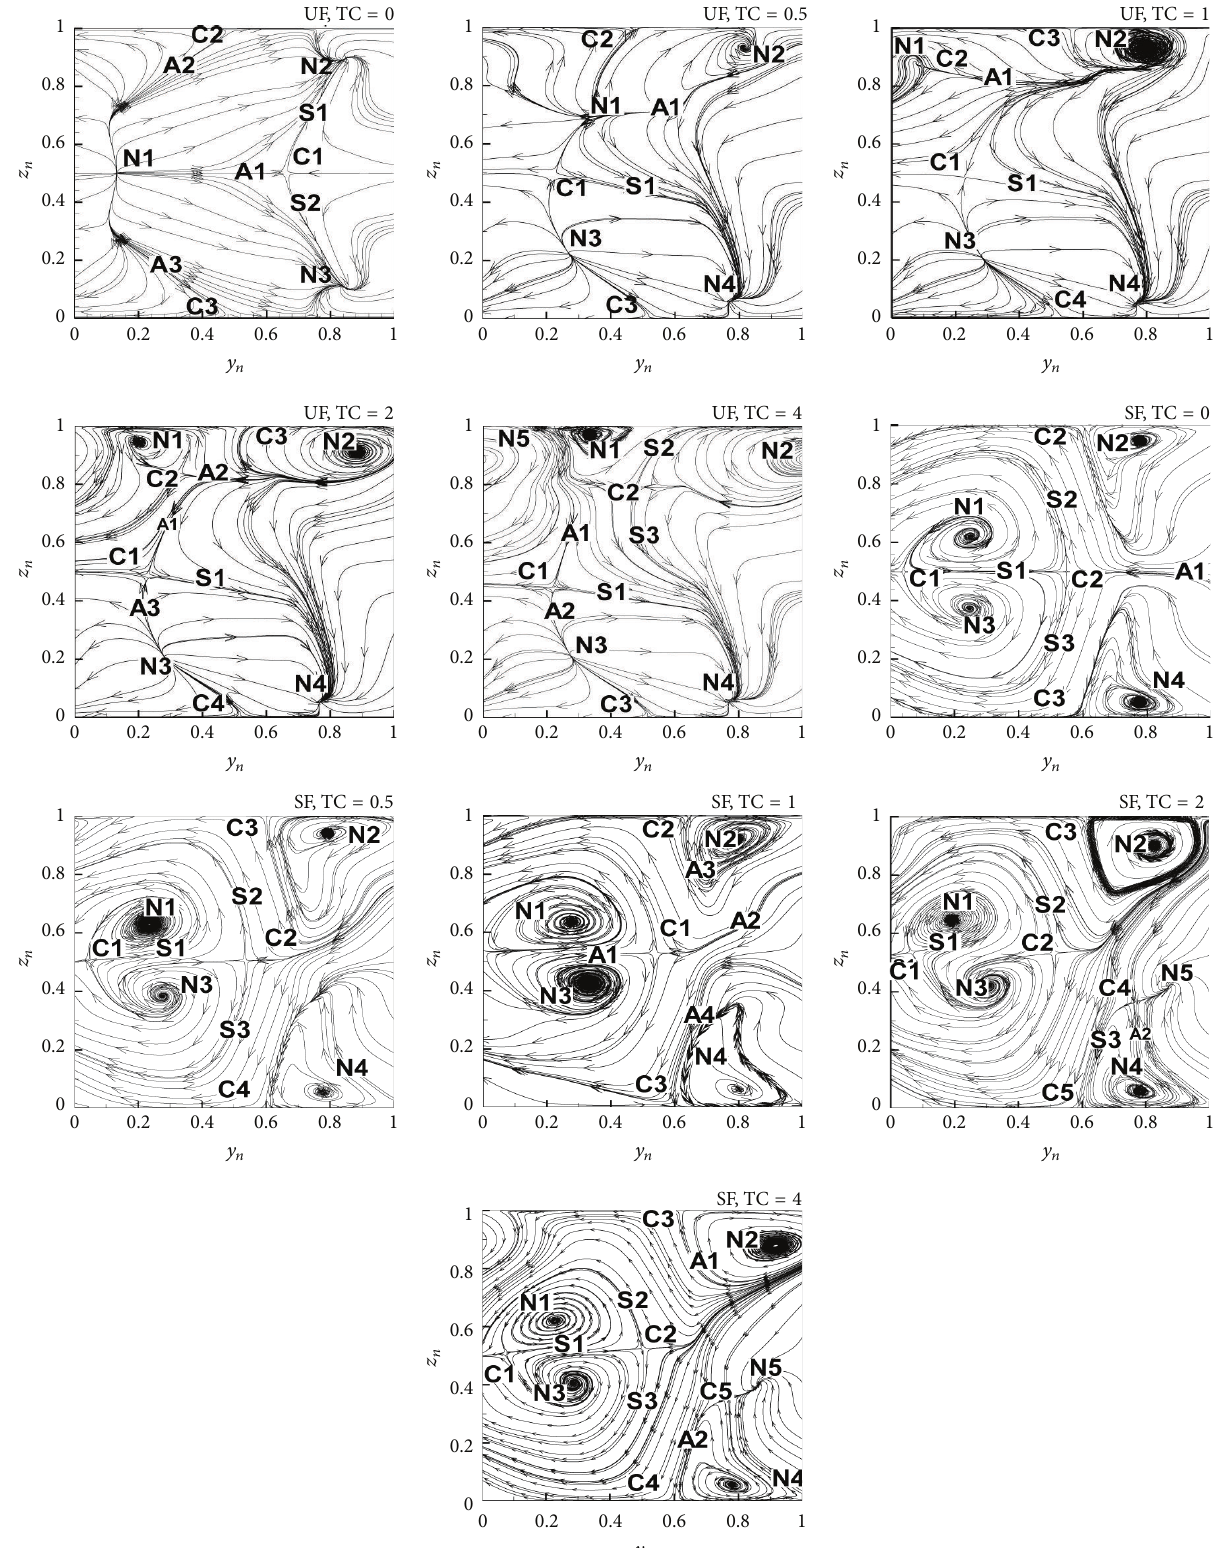
Figure 10: Streamline of secondary vectors in the wake along the direction of reference exit flow in the wake with UF and SF for TC = 0 to